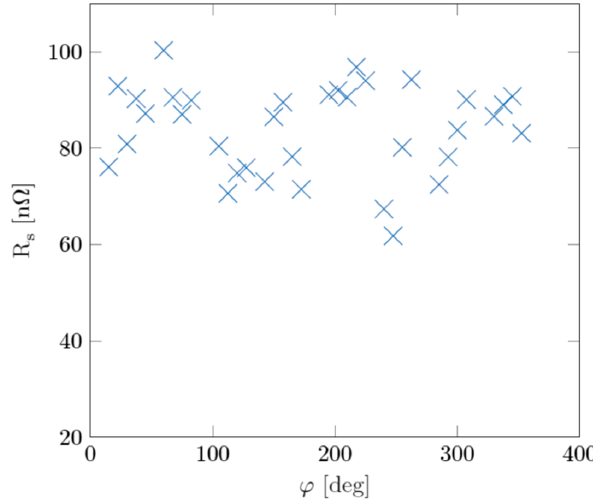
FIG. 15. Calculated surface resistance vs azimuthal angle, with applied field in α ¼ 90 °. The surface resistance is mapped similarly to Fig. 13. Blue marks show average surface resistance of each column in the corresponding map. The map is not depicted.